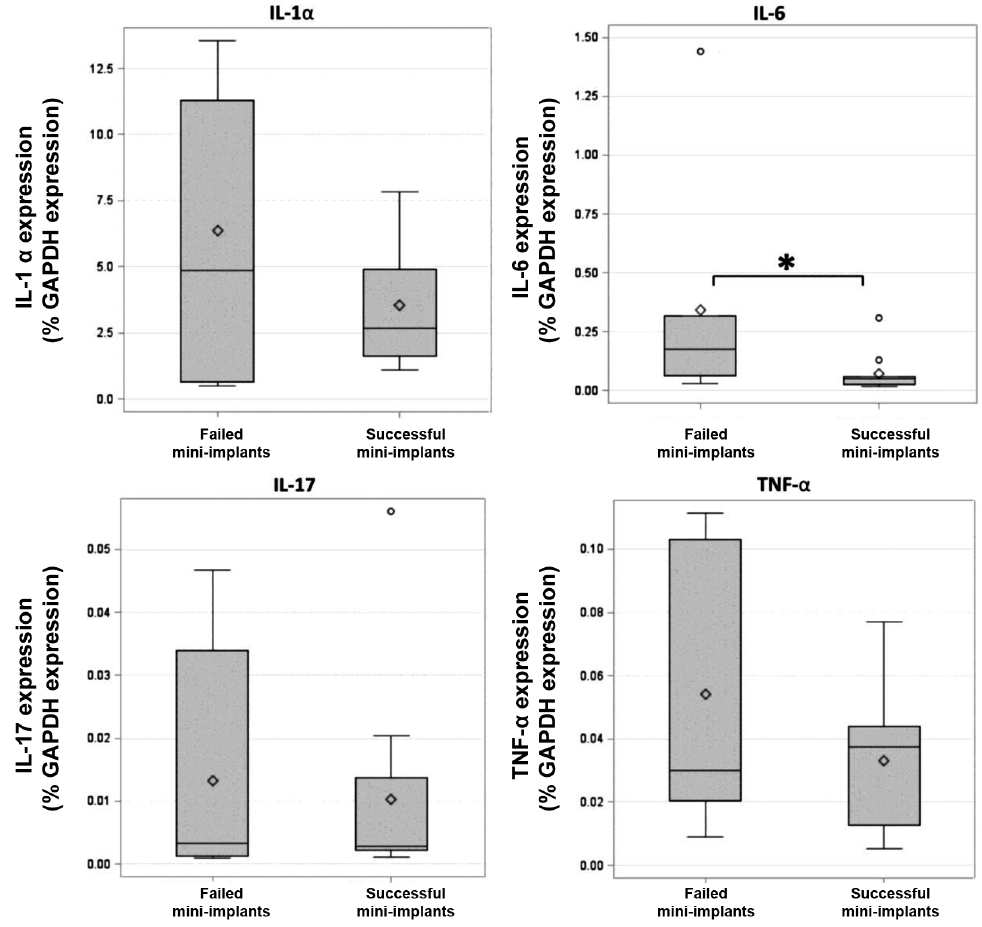
Figure 1- Quantification of cytokines IL-1 α , IL-6, IL-17, and TNF- α , presented in box-plots as percentage of GAPDH expression, in gingival tissue around successful and failed mini-implants. * p value=0.0397. * p statistically significant for the Wilcoxon rank-sum